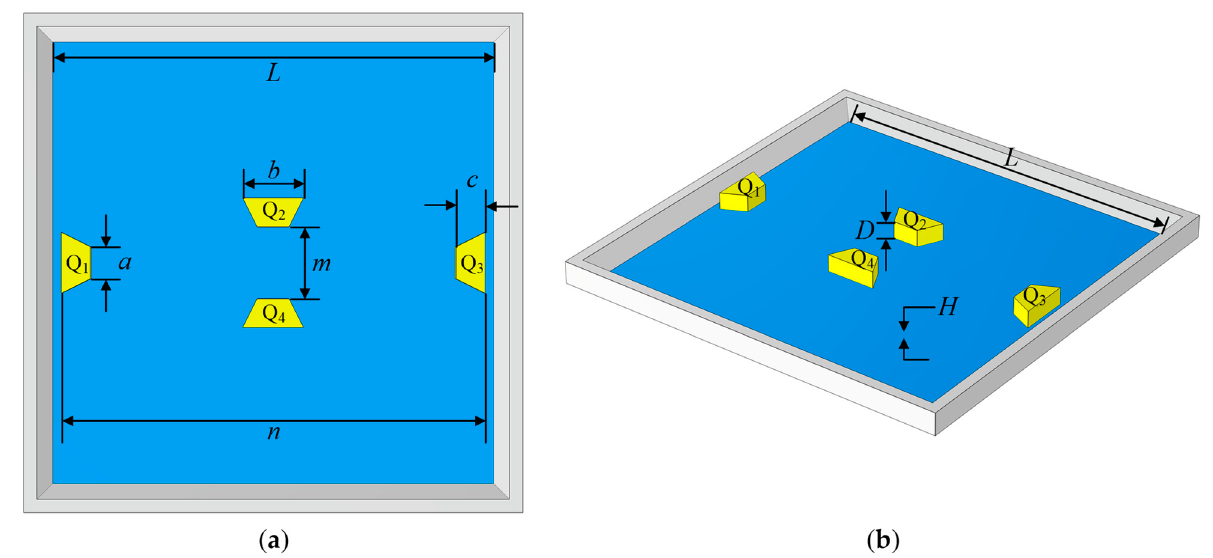
Figure 6. ( a ) Rear view and ( b ) isometric view of the proposed structure.